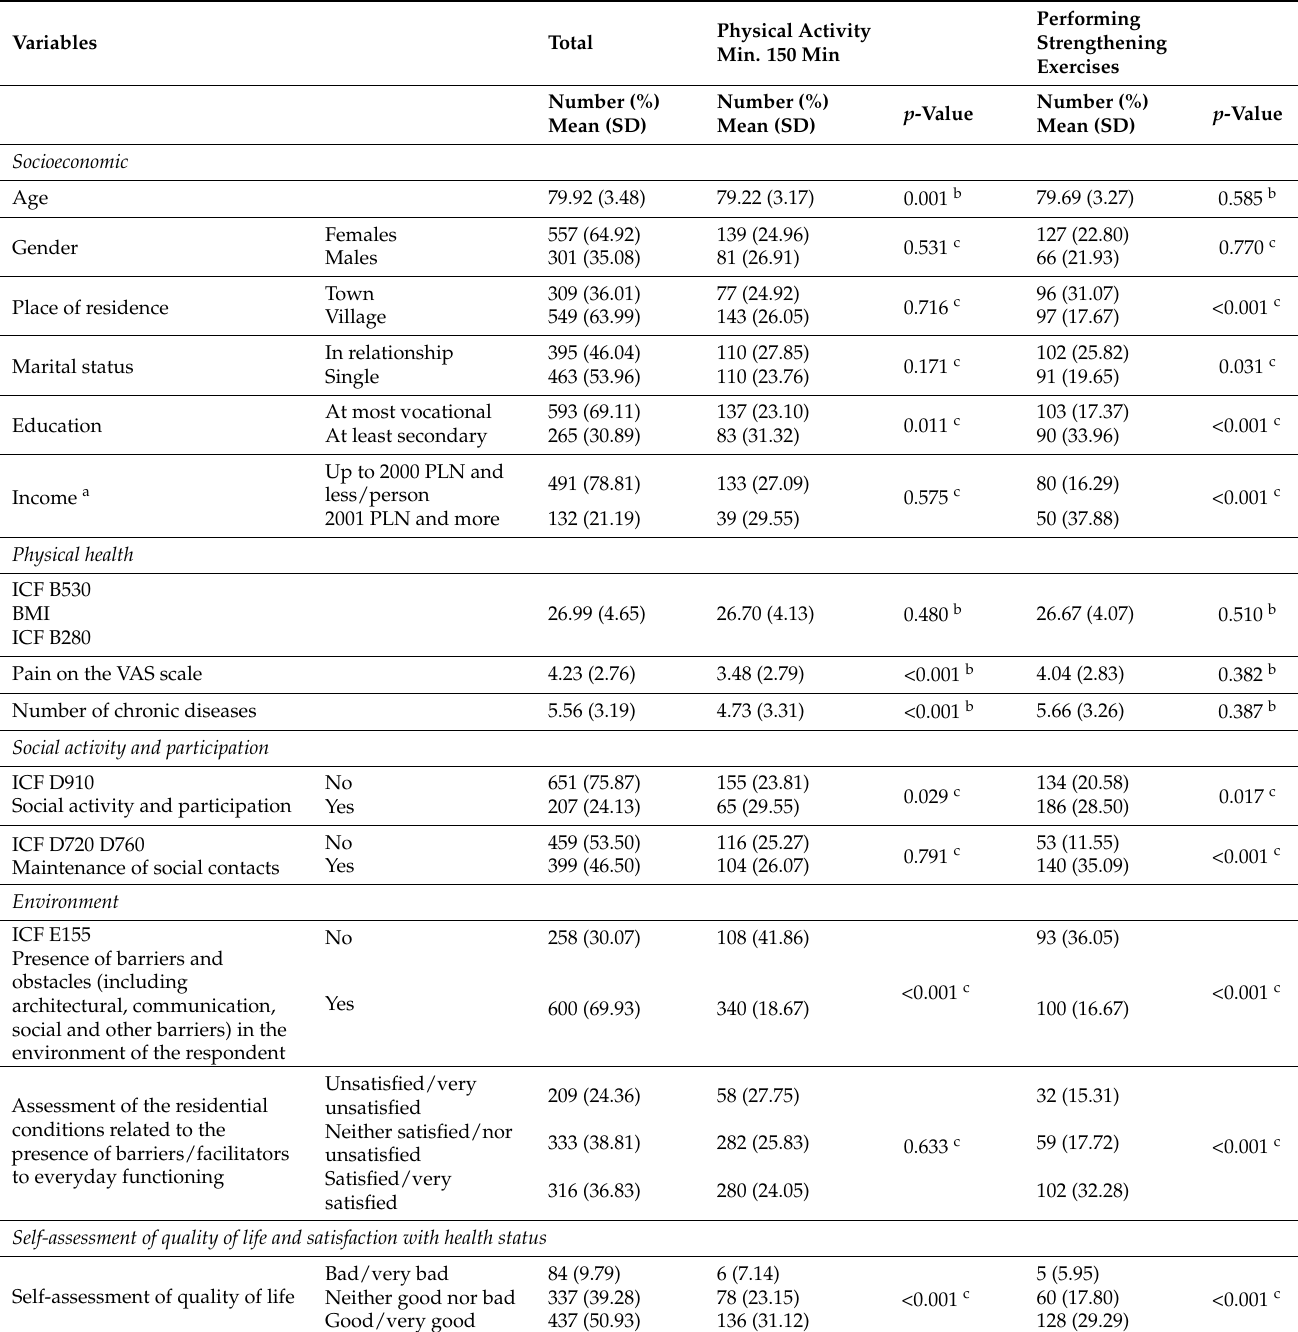
Table 1. Characteristics of the study population of people aged 75–90 years ( n =